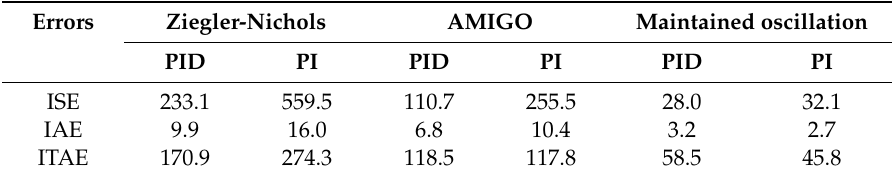
Table 4. Integral errors for PI and PID controllers.